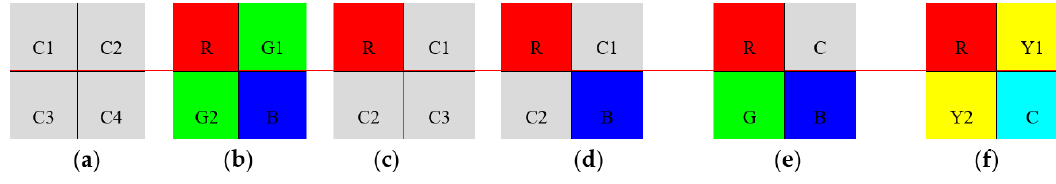
Figure 2. Color filter arrays: ( a ) monochrome (CCCC), ( b ) RGGB, ( c ) RCCC, ( d ) RCCB, ( e ) RGBC, ( f ) RYYC.